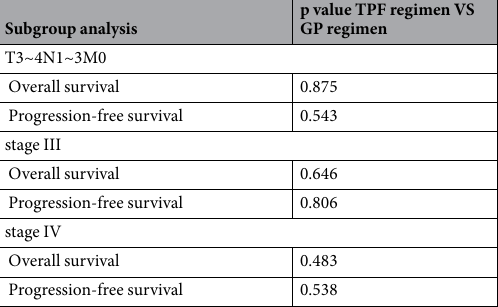
Table 4. Subgroup analysis.